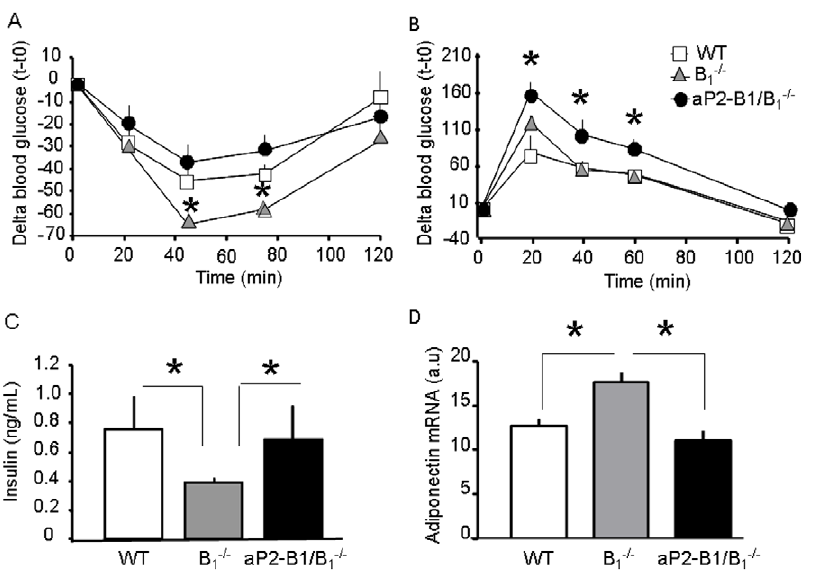
Figure 5. Kinin B 1 R in adipocytes contributes to glucose homeostasis. A: Insulin tolerance test; *, vs. WT and B 1 2 / 2 . B: Glucose tolerance test; *, vs. WT and B 1 2 / 2 . C: Serum insulin levels. D: Adiponectin expression as quantified by realtime PCR. Values are means 6 SEM of six animals per group. *, P , 0.05.